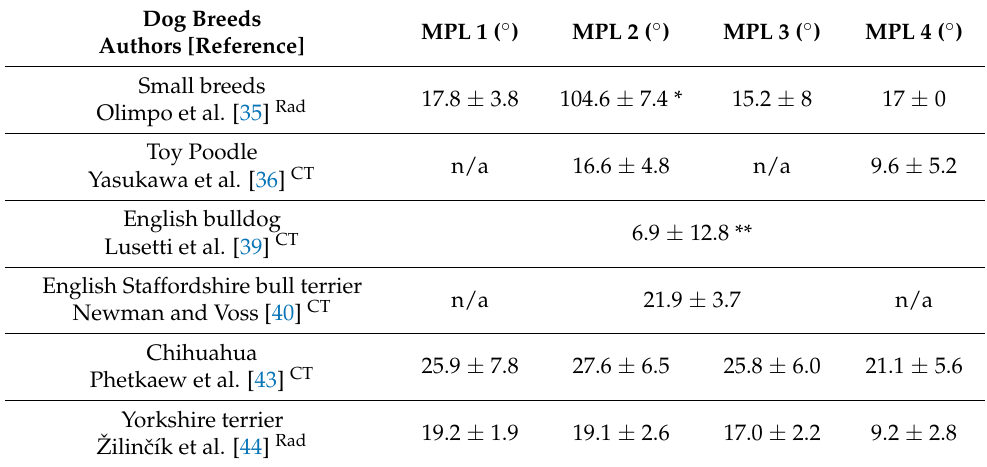
Table 13. Mean ± standard deviation of the angle of anteversion in dogs with different grades of